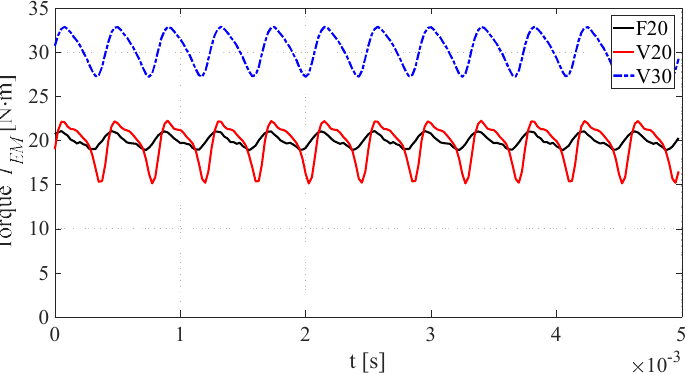
Figure 18. Distribution of magnetic flux distribution of selected geometries ( a ) F20, ( b ) V20, and ( c ) V30.